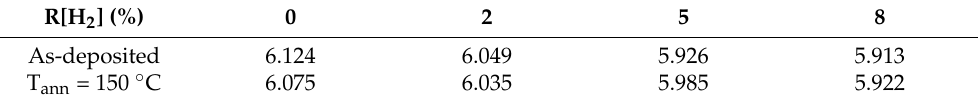
Table 4. IGZO and IGZO:H film density (g/cm 3 ) change after deposition at different R[H 2